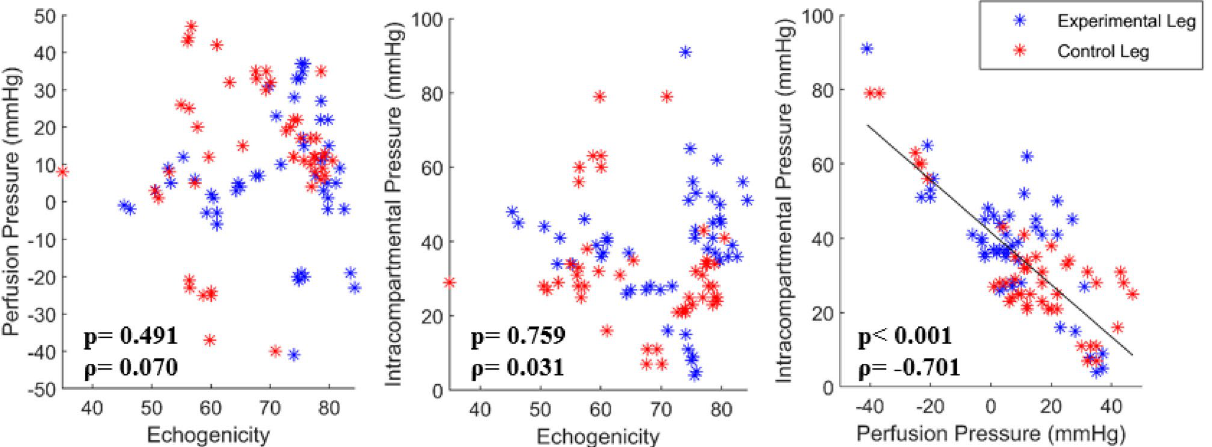
Figure 3. Echogenicity vs. intracompartmental pressure, echogenicity vs. perfusion pressure, and intracompartmental pressure vs. perfusion pressure in the echogenicity group (EG). Each blue asterisk indicates each data point from all time points of the experimental leg, and each red asterisk indicates each data point from all time points of the control leg in the EG.